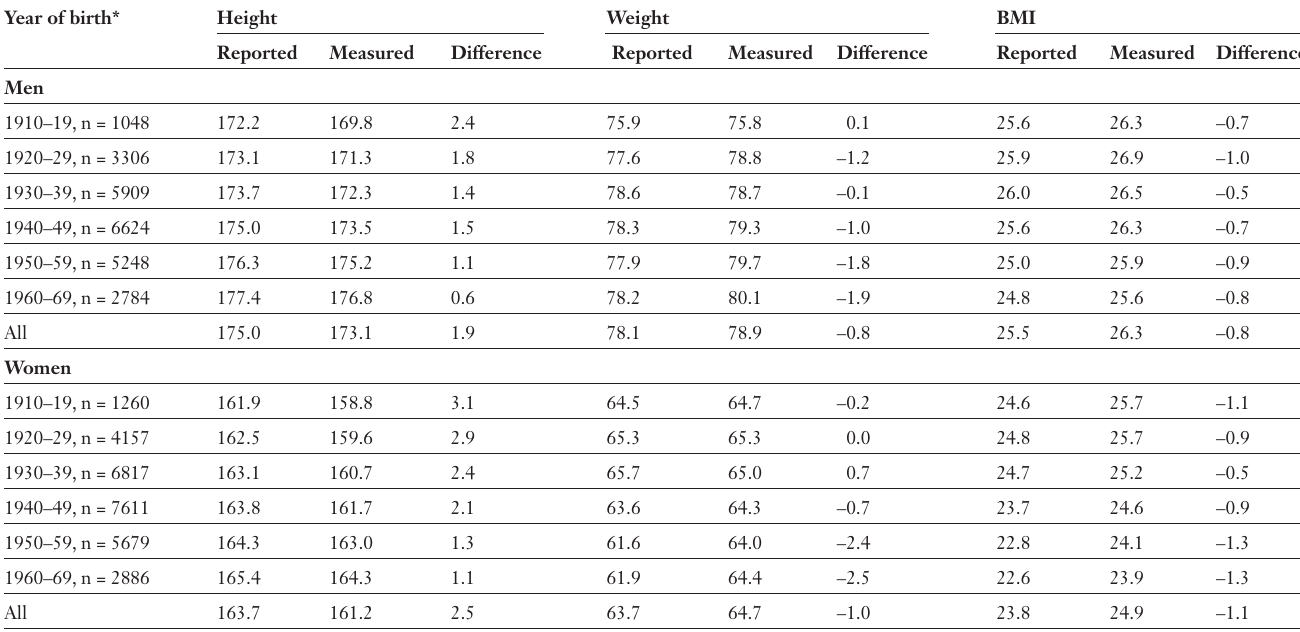
Mean (%) height, weight and BMI by year of birth and type of assessment (self-reported vs measured